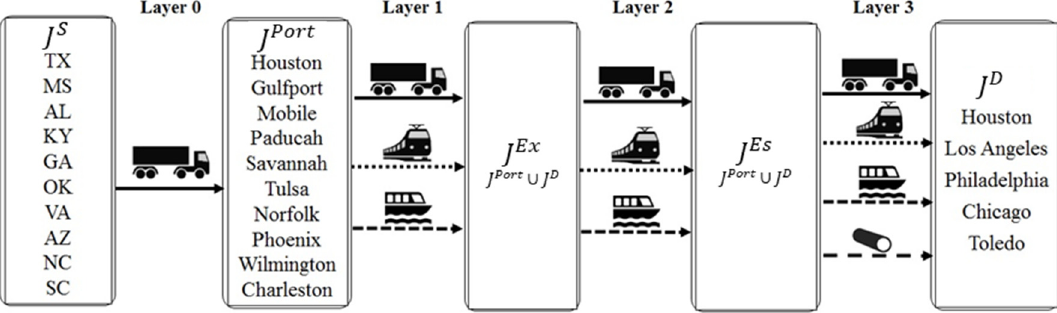
Figure 11. Condensed network flow diagram of the algal biomass to biodiesel problem for the case of the contiguous United States.